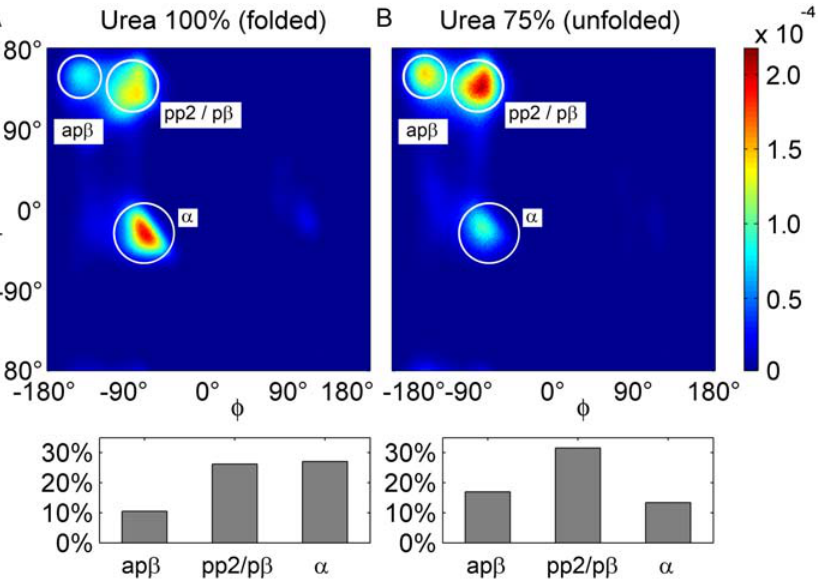
Figure 6. Ramachandran plots for (A) CI2 in urea 100% (folded state), (B) CI2 in urea 75% (unfolded state). The white circles show the areas which have been used for the calculation of populations densitites, which are shown in the lower panel for antiparallel b -sheet (‘‘ap b ’’), PP2 or parallel b -sheet (‘‘pp2/p b ’’), and helical ( a ) configurations.